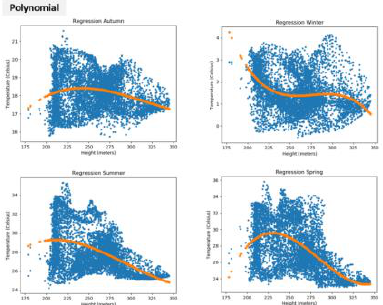
Figure 18: Polynomial Regression Model LST in 4 seasons (Temperature vs. Height)